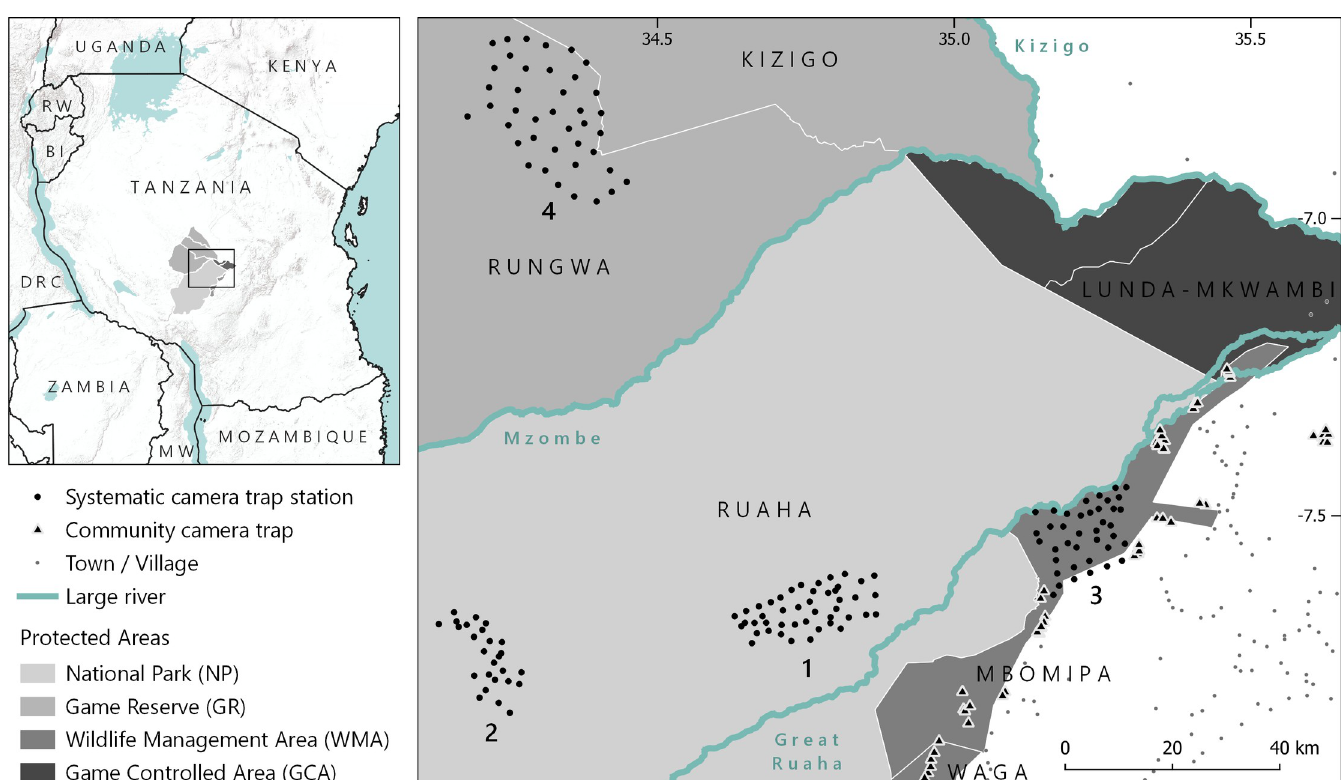
Fig 1. Left: the location of the Ruaha-Rungwa landscape within Tanzania (World Terrain Base by Esri, USGS, & NOAA). Right: detail of the four systematic camera trap grids, comprising a total of 151 camera pairs, and the 56 unpaired cameras deployed in village land as part of a community camera-trapping programme (made with Natural Earth). Systematic camera trap grids were located in (1) Ruaha NP Acacia-Commiphora habitat, (2) Ruaha NP miombo habitat, (3) MBOMIPA WMA Acacia- Commiphora habitat, and (4) Rungwa GR miombo